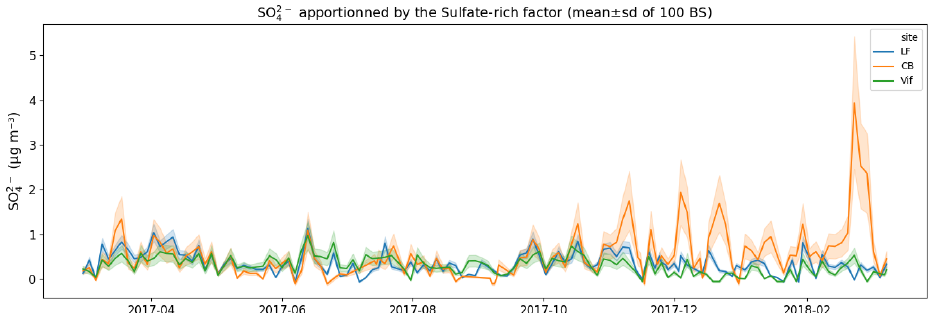
Figure 9. SO 2 − apportioned by the sulfate-rich factor at the three sites, according to the uncertainties given by the 100 BS as shown by the 4 mean (solid line) and the standard deviation (shaded